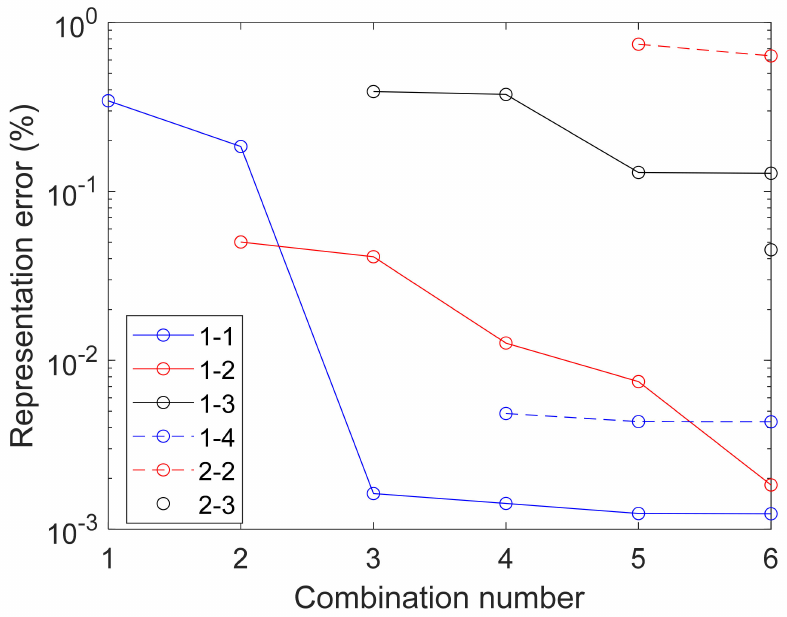
Figure 24. Representation errors of the combinations 1-1, 1-2, 1-3, 1-4, 2-2, and 2-3 at the end of the POD analysis for each of these combinations taking 2, 3, 2, 1, 2, and 1 duals.